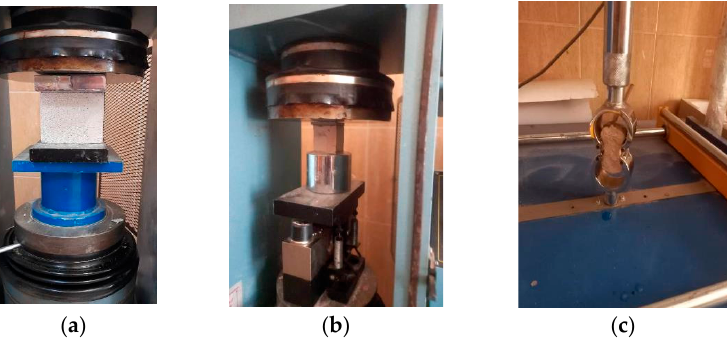
Figure 4. Test setup for ( a ) compressive strength of AAC materials; ( b ) compressive strength of adhesive materials; ( c ) tensile strength of adhesive materials.